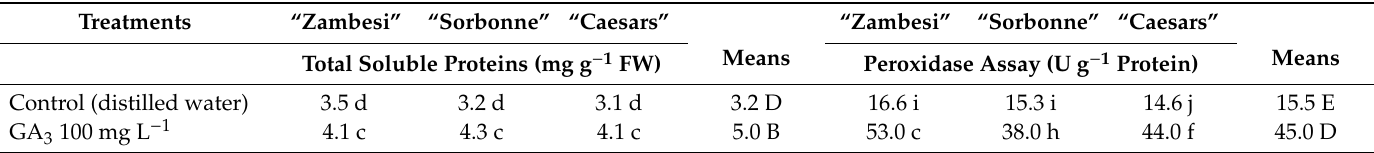
Table 4. Comparative analysis of the e ff ects of di ff erent vase solutions on the total soluble proteins, peroxidase assay, catalase assay, and superoxide dismutase assay of three cultivars of cut lily